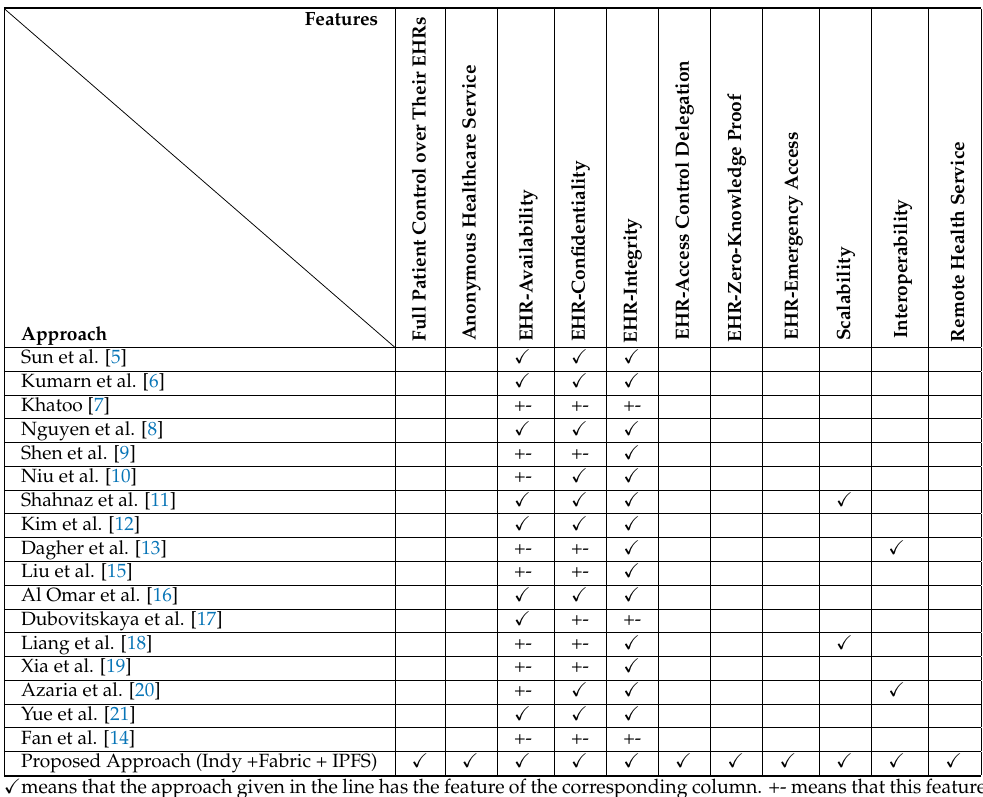
Table 13. Evaluation of related work and the proposed solution.